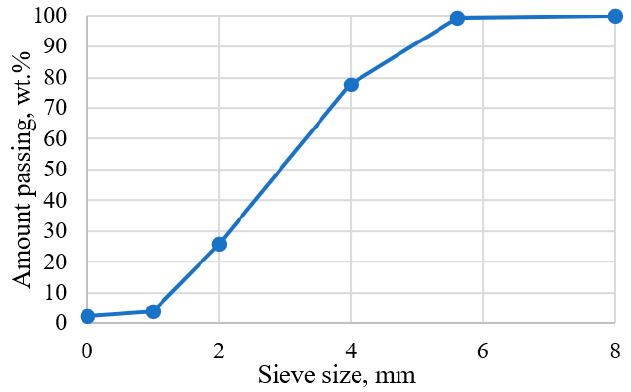
Figure 7. Particle size distribution of EPS granulate.